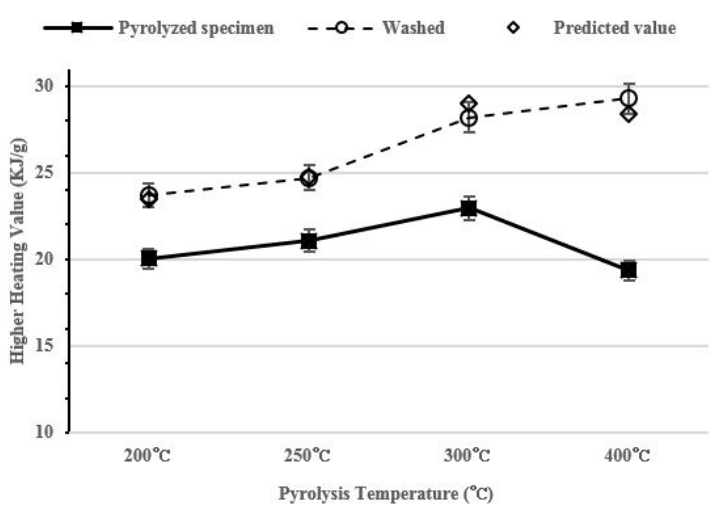
Figure 6. Higher heating value (HHV) per pyrolysis temperature.